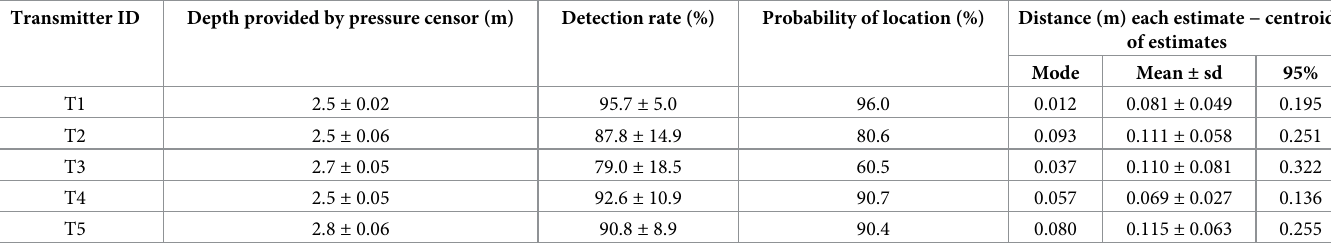
Table 3. Summary of the positioning results of the five transmitters employed during stationary testing. Transmitter ID Depth provided by pressure censor